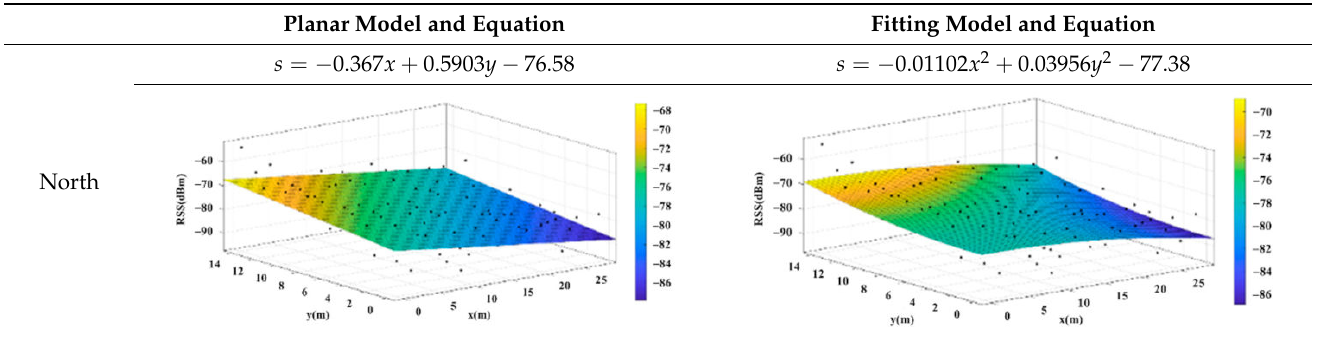
Table 6. Models and Equations Generated from the Four Directions in the Experimental Environment for Base Station